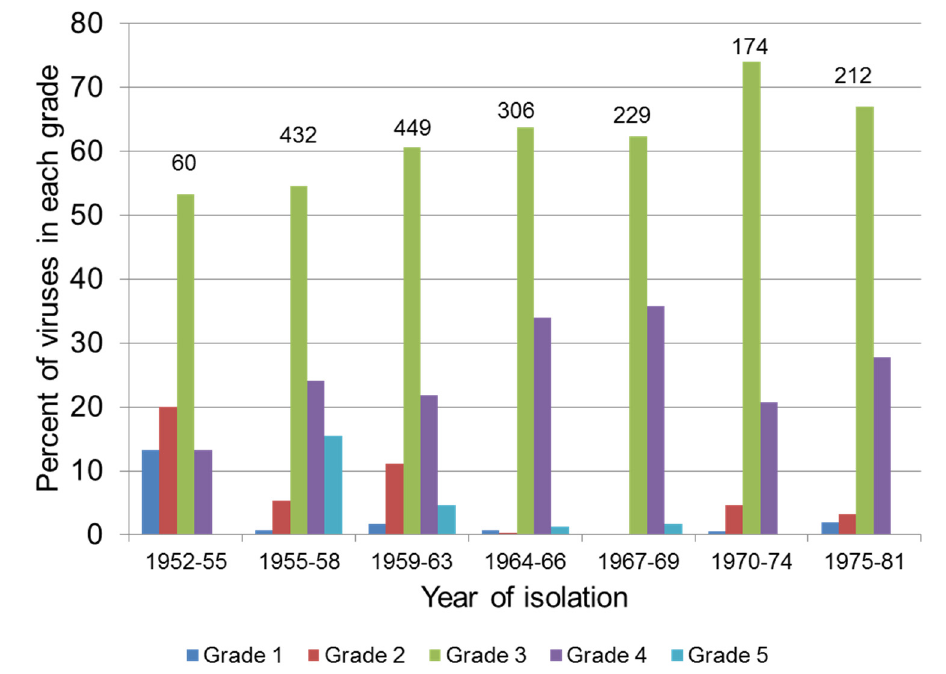
Figure 1. Virulence of Myxoma virus isolates in Australia 1952–1981. The proportion of MYXV isolates in each virulence grade (Table 5) is shown. Numbers above the bars indicate the number of isolates tested for each period. Grade 3A and 3B viruses are combined as grade 3. Data are from [137]. Figure is reprinted from Antiviral Research [64] (with permission from